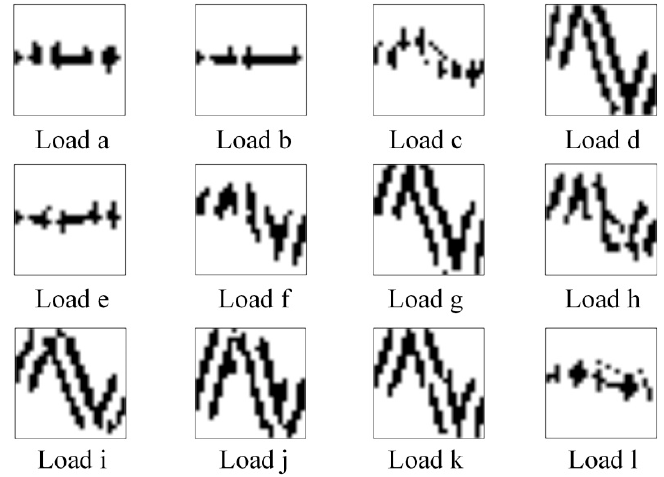
Figure 13. Feature image after the first convolution operation.